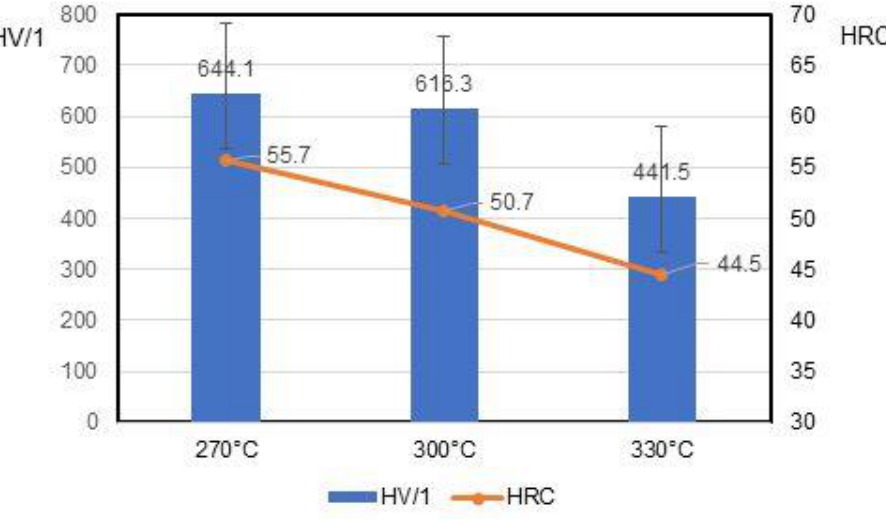
Figure 7. Vickers HV/1 and Rockwell HRC hardness of ADI samples treated at different tempera- tures.